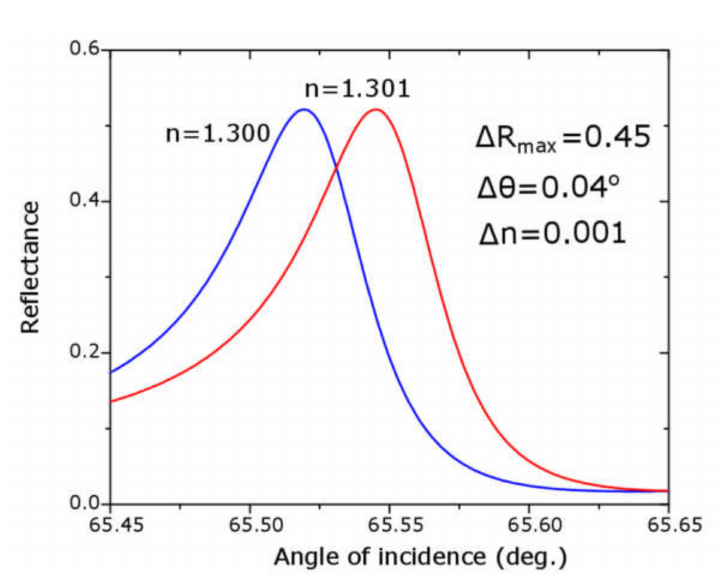
Figure 9. Theoretical ATR spectrum (t H = 139 nm) near Fano resonances for samples with refractive index near water, which shows the possibility to improve sensitivity parameters by changing the refractive index of the L-layer. By using n L = 1.35 and the other parameters equal to those of spectra in Figure 6c, it is possible to obtain for sensing media with a refractive index near water: S θ = 30 deg RIU − 1 and FOM = 450 RIU − 1